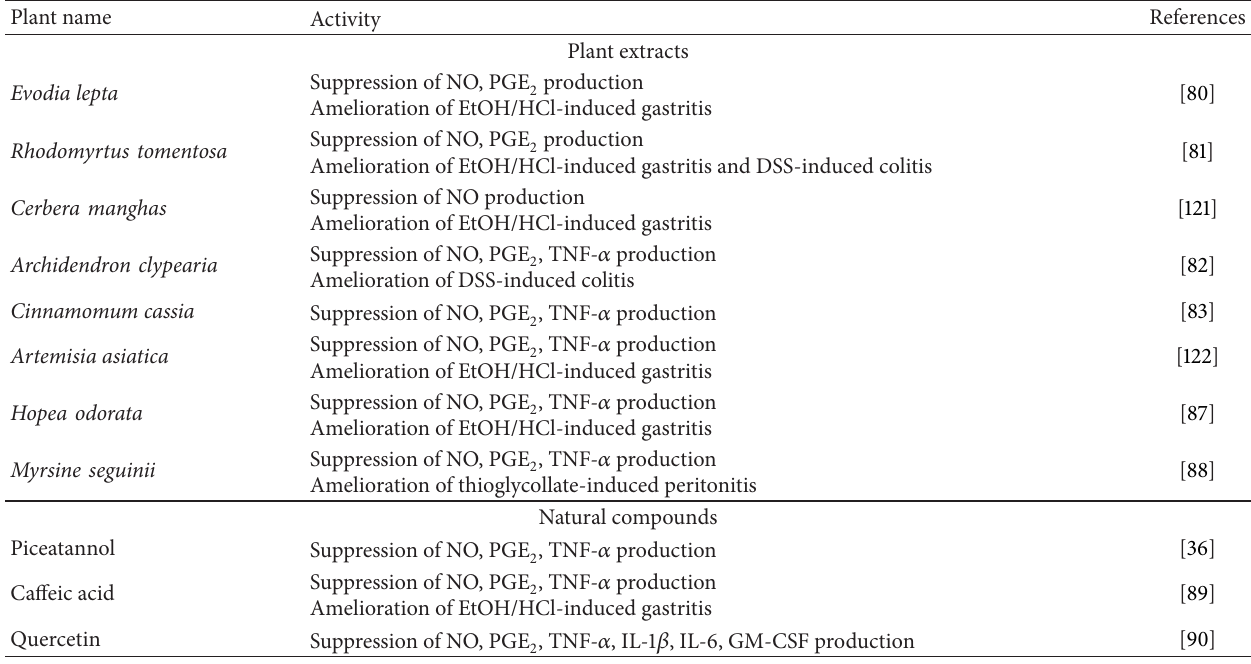
Table 2: Summary of the plant extracts and naturally occurring compounds targeting